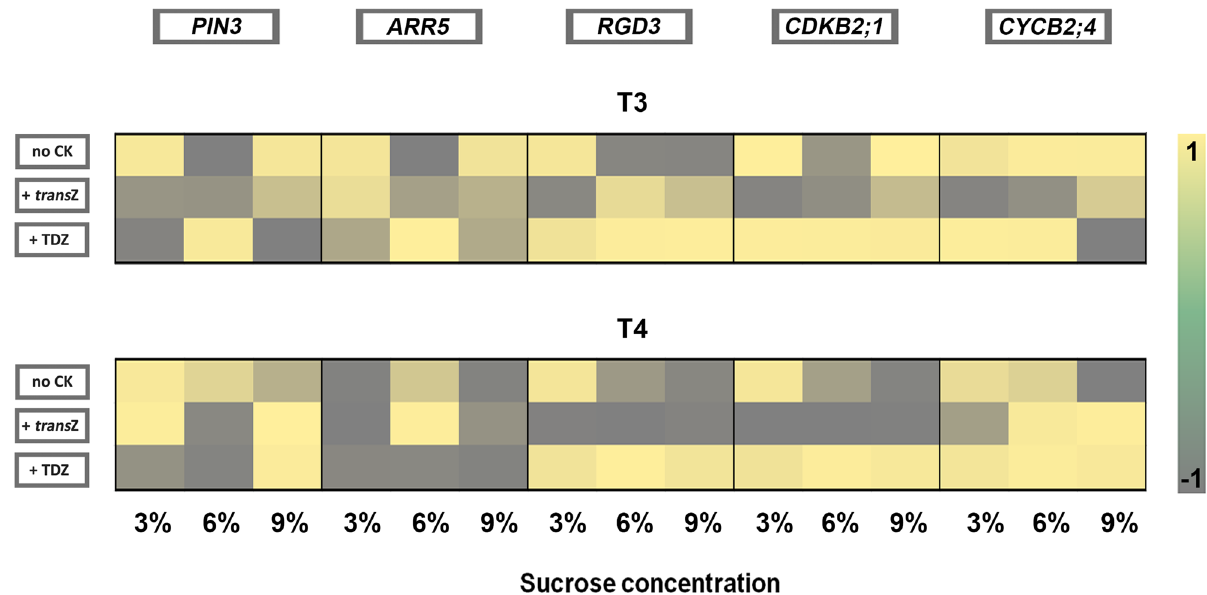
Figure 6. Heat map representing Pearson’s correlation coefficient (r) calculated between content of CK nucleobases and absolute gene expression of differently treated kohlrabi (cv. Vienna Purple) seedlings for T3 and T4 stages of de novo shoot